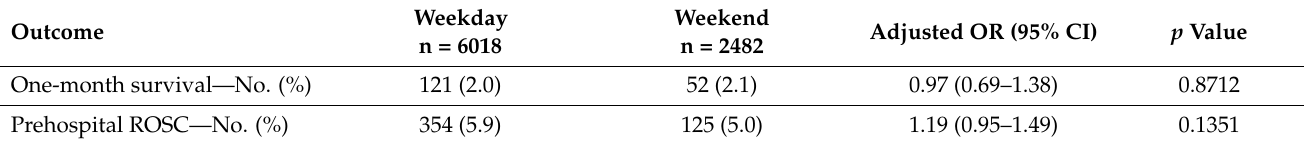
Table 3. Outcomes for traumatic OHCA during weekday vs. weekend.